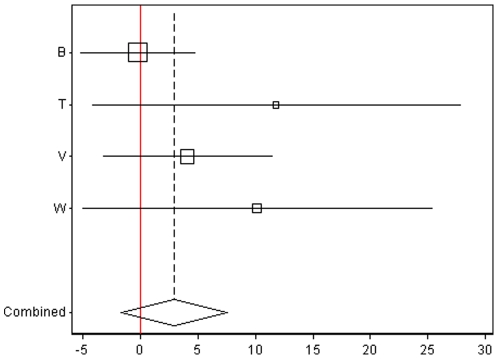
Associations (with 95% CI) of living within 100 m of a highway and CIMT progression by trial and the respective meta-analytic estimate.The X-axis indicates the regression coefficient (change) in micrometers. Studies: B = BVAIT, T = TART, V = VEAPS, W = WELLHART. Among the EPAT participants, no subject lived within 100 m of a major road. The solid line indicates the level of no effect.